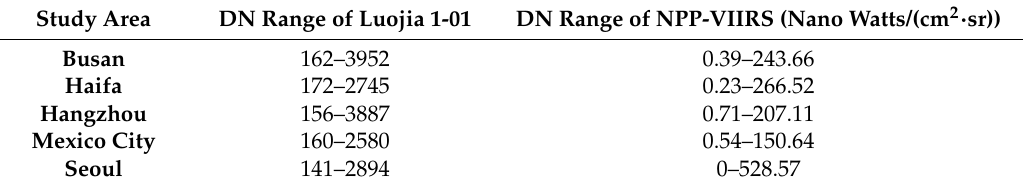
Table 3. The digital number (DN) range of Luojia 1-01 and Suomi National Polar-Orbiting Partnership Visible Infrared Imaging Radiometer Suite (NPP-VIIRS) in six cities.